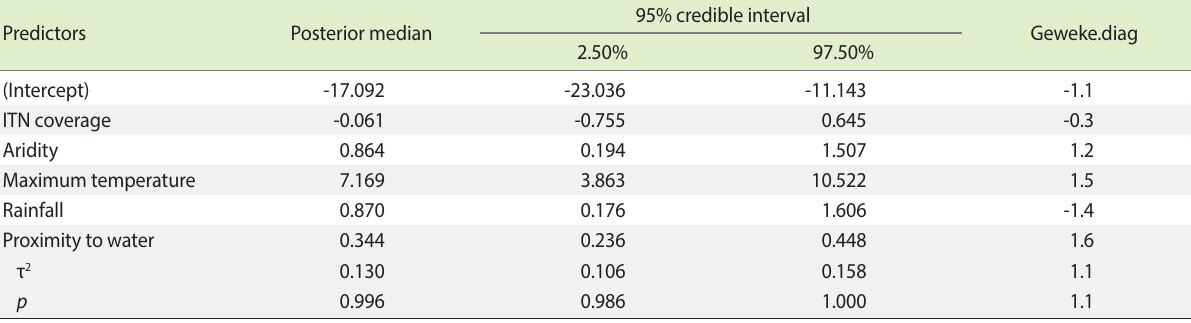
Table 5. Bayesian hierarchical regression of the predictors of malaria prevalence Predictors Posterior median